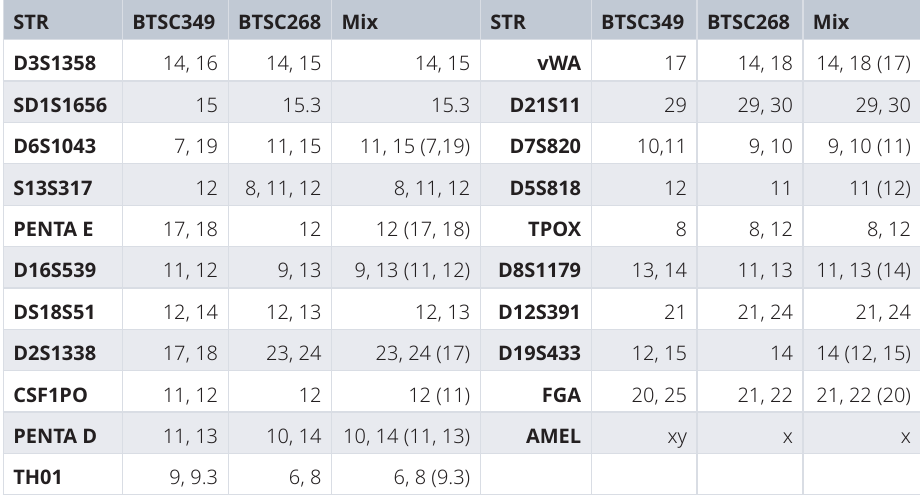
Table 1. Short tandem repeat (STR) profile of contaminated brain cancer cell line mix assumed to be BTSC349 (mix), which got contaminated with BTSC268 cells. For comparison and a reference for the scientific community, STR profiles of parental lines are provided as well. STRs with mixes of both cell lines are marked. For original data as supplied by in-house service, see underlying data 11